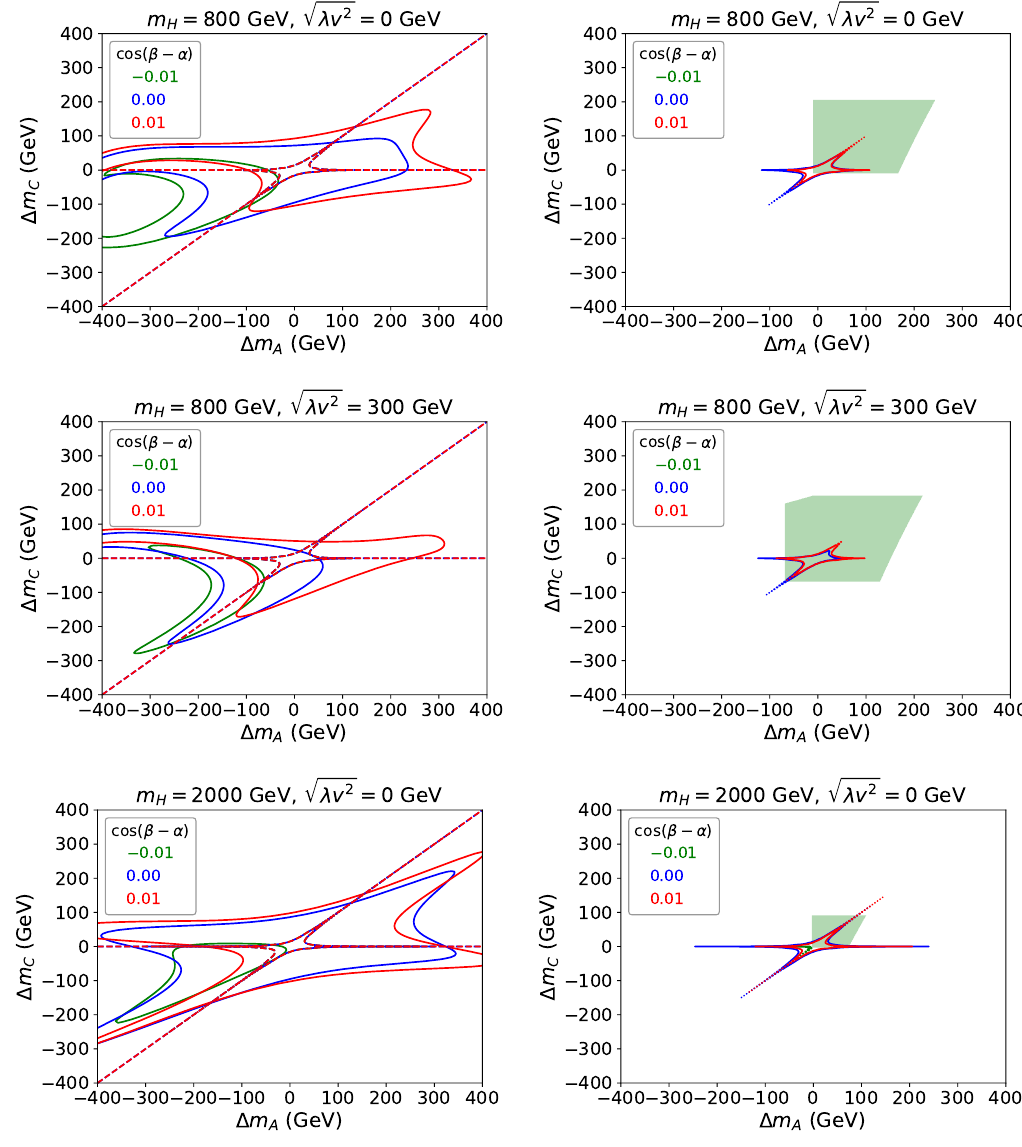
Figure 12 . Updated on July 17,